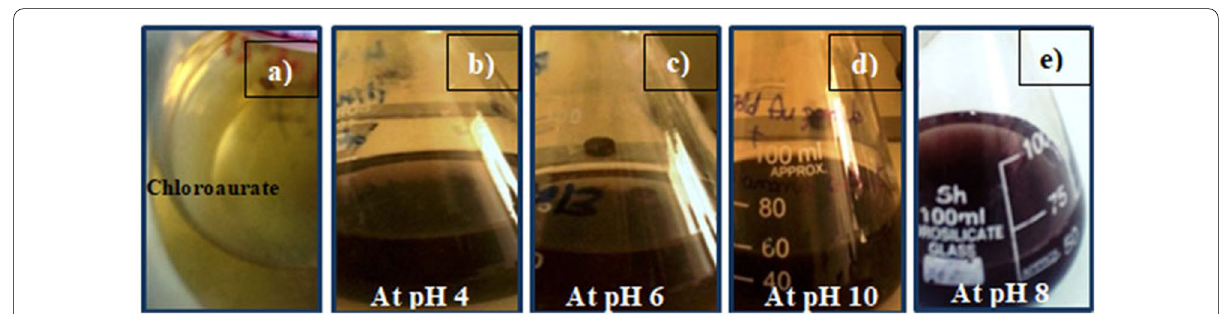
Fig. 8 a – e Chloroaurate and nanoparticles synthesis at different